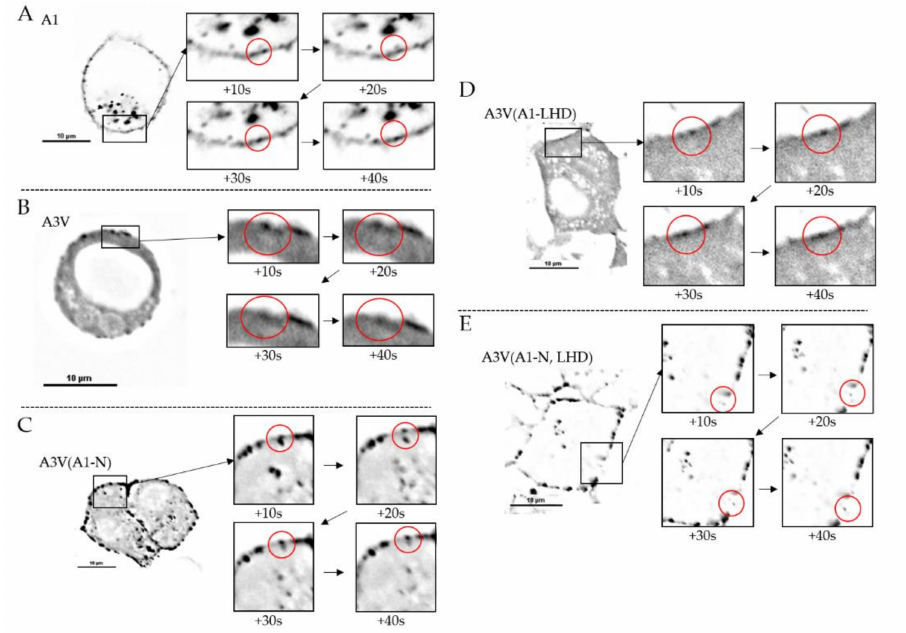
Figure 5. Time-lapse imaging of EGFP-LC/A. After a five-hour transfection of the indicated EGFP- LC/A ( A ); EGFP-LC/A1 (A1) ( B ) EGFP-LC/A3V (A3V) ( C ); EGFP-LC/A3V(A1-N), (A3V(A1-N)) ( D ); and EGFP-LC/A3V(A1-LHD) (A3V(A1-LHD)) ( E ). EGFP-LC/A3V(A1-N, LHD) (A3V(A1-N, LHD)) and N2As were imaged on a Nikon Eclipse Ti2 microscope equipped with a W1 Spinning Disc, Orca Flash CMOS camera, and 60 × oil-immersion objective (CFI Plan Apo λ , 1.4 NA objective) confocal microscope [33]. Live-cell images were obtained every 10 s for 10 min. Images were deconvoluted with Nikon Elements Deconvolution Software (Version